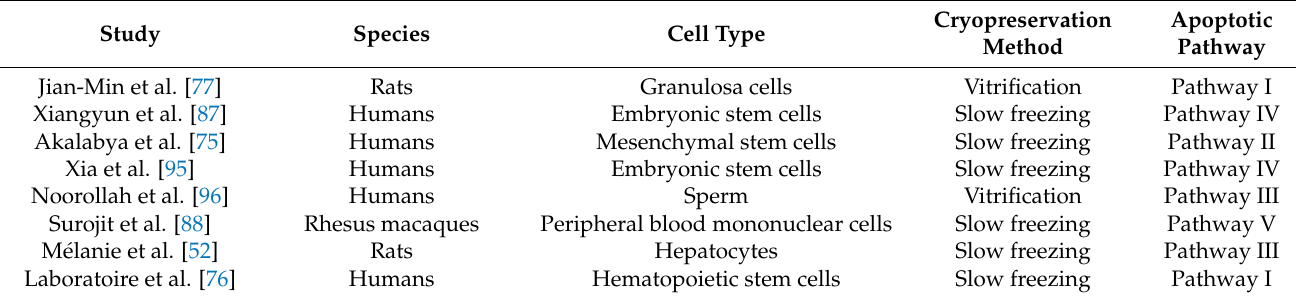
Table 1. Low temperatures activate apoptotic pathways.